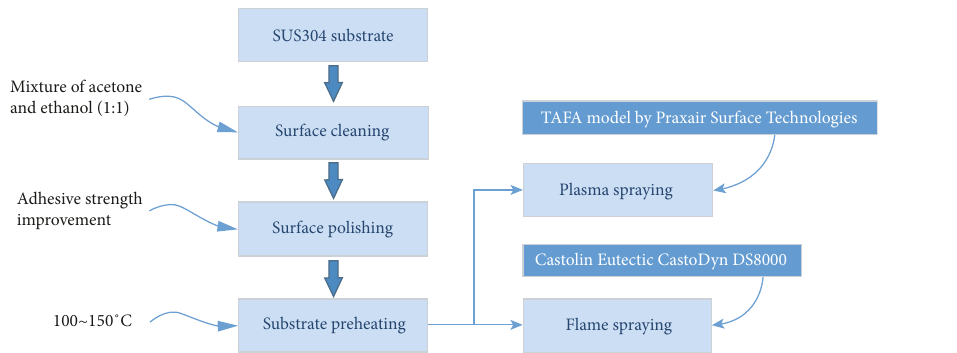
Figure 1: Schematic of thermal spraying process.